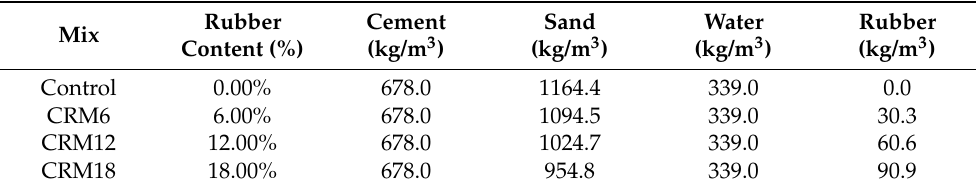
Figure 1. 2 – 4 mm rubber granules. Table 1. Mix proportions of CRM. Table 1. Mix proportions of